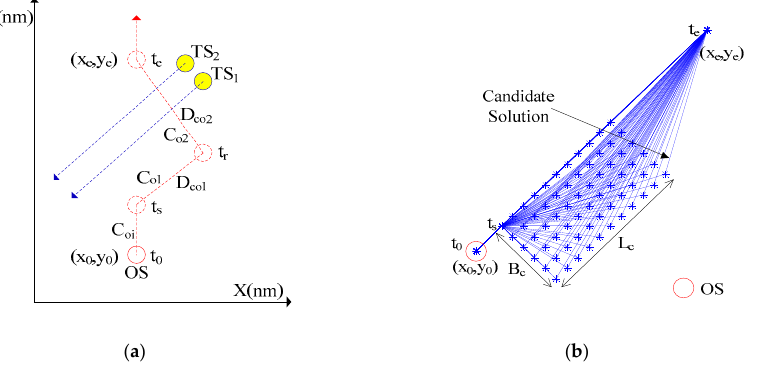
Figure 4. Deterministic optimization algorithm: ( a ) Process of path planning for collision avoidance; ( b ) candidate solutions for collision avoiding path.